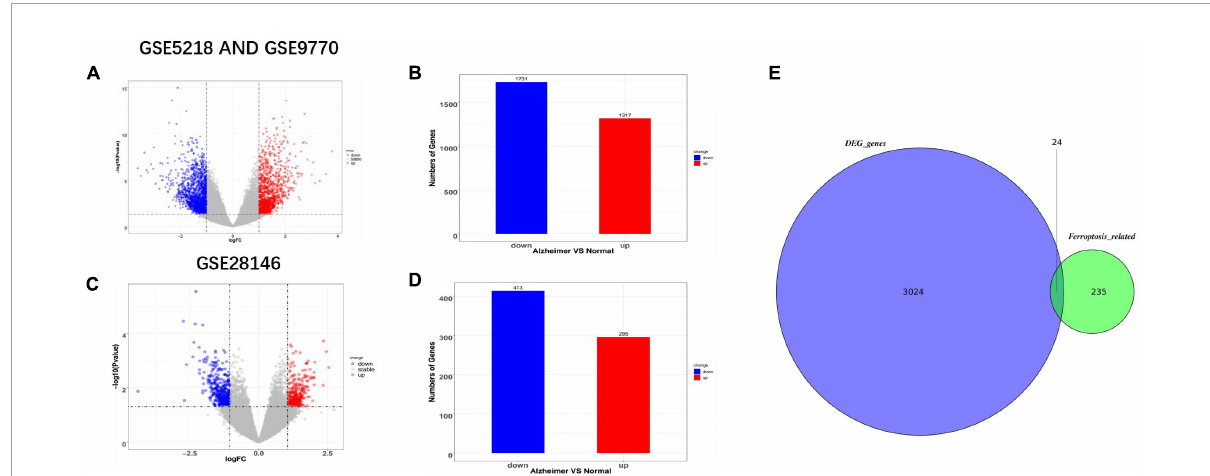
FIGURE1 Identification of differentially expression genes (DEGs) and ferroptosis-related genes. (A,B) Volcano plot and bar plot of AD and non-AD patients in GSE5218 and GSE9770 after merging and removing any batch effects. (C,D) Volcano plot and bar plot of AD and non-AD patients in GSE28146. (E) Venn diagram showing the intersection of ferroptosis-related DEGs in the combined set. AD, Alzheimer’s Disease; DEGs, differentially expressed genes.